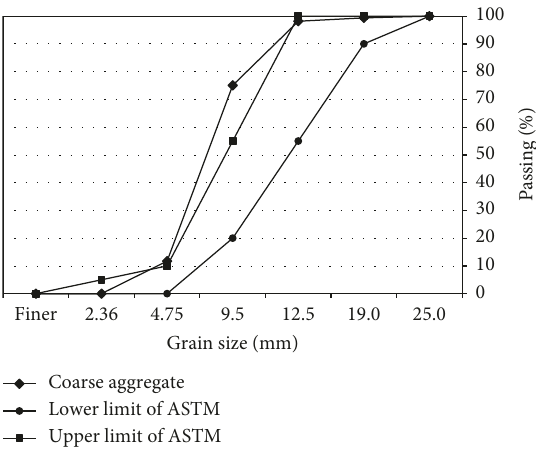
Figure 1: Grading curve of coarse aggregates.